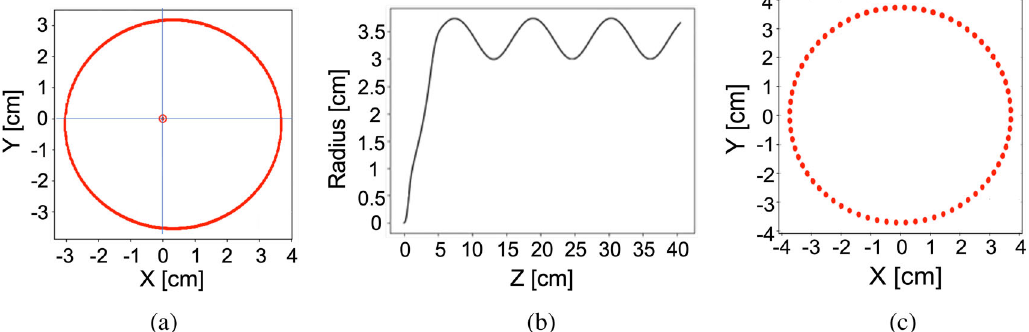
FIG. 3. (a) Projection on a plane transverse to the cavity axis over one or more rf periods of the eccentric helical orbit of an accelerated particle. Note the 0.35 cm offset of this helix ’ s axis from (0,0). (b) Plot of the radial coordinate of a particle along z showing the undulation from its initial radial kick that causes the offset of eccentric helical orbits. (c) Superposition over a full cycle of the loci of orbit intersections where particles intersect a target beyond the cavity. This shows how an eCRA beam is centered on (0,0), how it would scan and deposit its energy uniformly around a circle on a target, and how it remains unbunched.